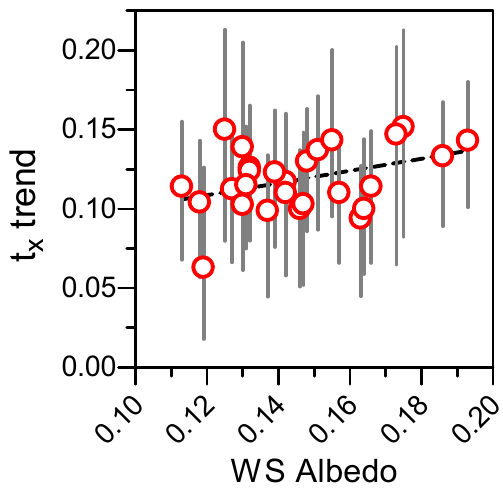
Figure 5. Linear relationship between WS albedo of area surrounding the weather stations and their warming trends for mean maximal temperatures (red circle ± 95% CI) from April to June, expressed in °C year −1 .